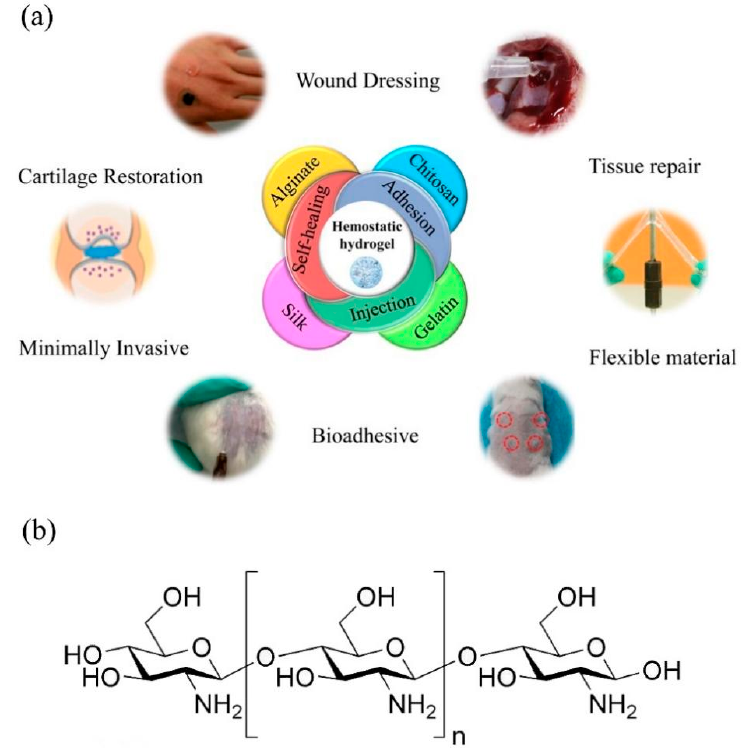
Figure 1. ( a ) Properties and applications of hemostatic hydrogels prepared from different poly- mers [23–28]. Copyright 2019, 2021 Elsevier. Copyright 2022 Taylor & Francis Group. Copyright 2019, 2021 American Chemical Society. ( b ) Chemical structure of